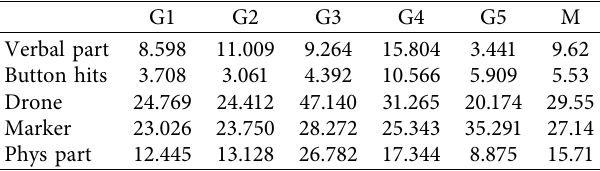
Table 4: Equity of participation related to amount of speech, button hits, drone usage, marker usage, and physical participation. G1 G2 G3 G4 G5 M Verbal